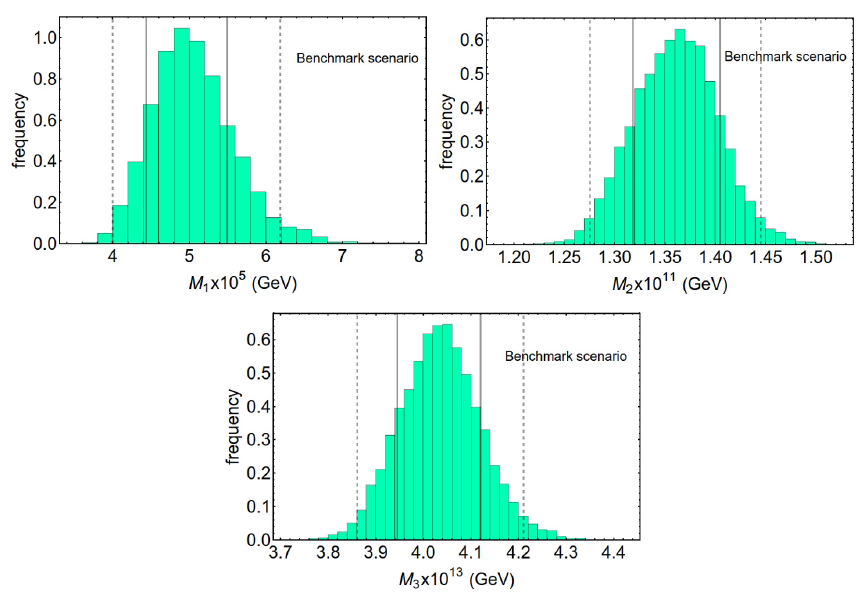
Figure 5 . Right-handed neutrino masses in the benchmark scenario resulting from MCMC analysis. The vertical solid (dashed) line corresponds to 1 σ ( 2 σ ) highest posterior Density (HPD) for the masses M i .